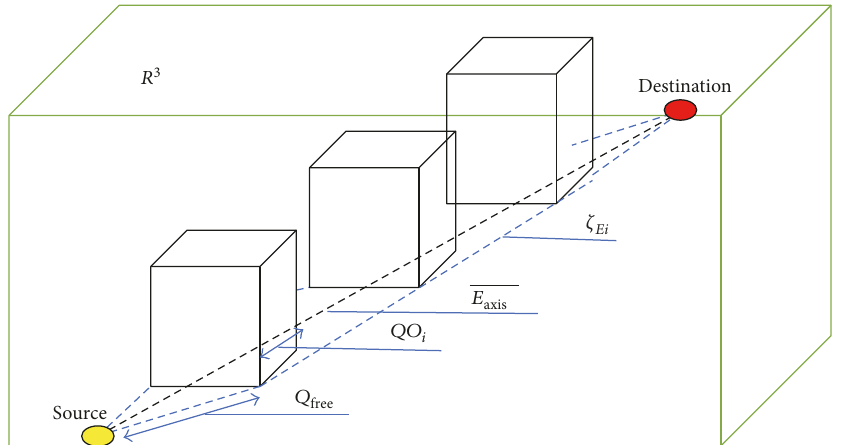
Figure 7: Illustration of the bounded energy space creation. The green outlined cuboid represents the con fi guration space R 3 . The black dashed line represents the energy axis E axis . The blue dashed boundary represents the bounded energy